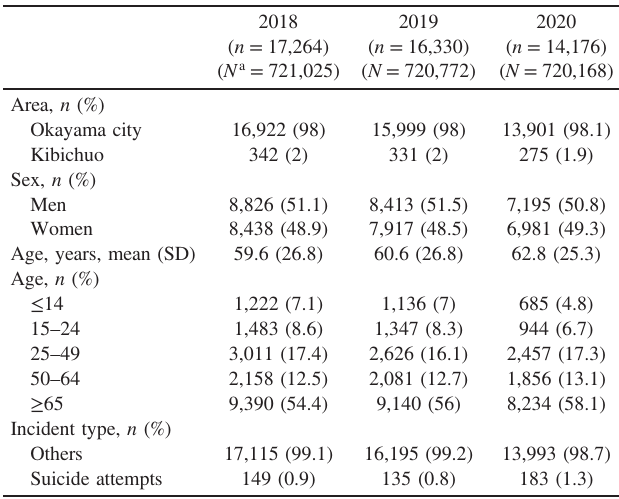
Table 1. Demographic characteristics of study subjects obtained from information on emergency dispatches in